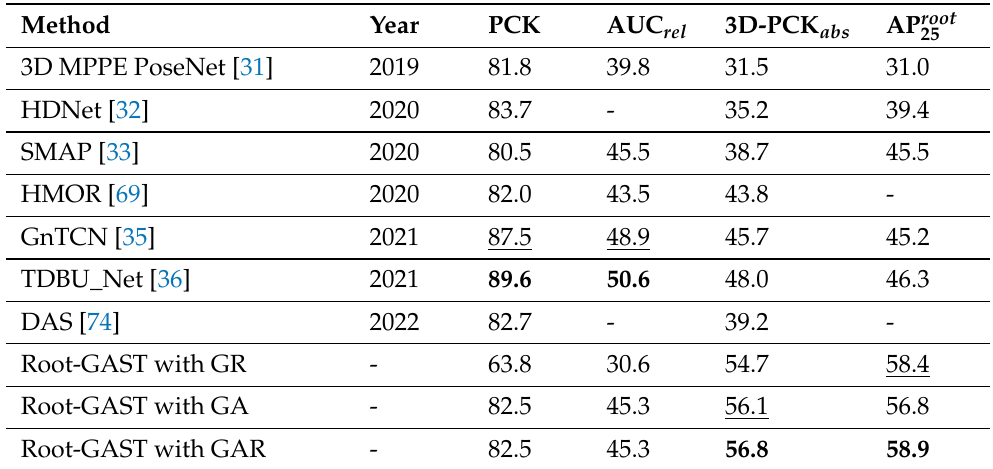
Table 1. Person-centric and camera-centric evaluations on the MuPoTS-3D dataset. The best is in bold, the second best is underlined.